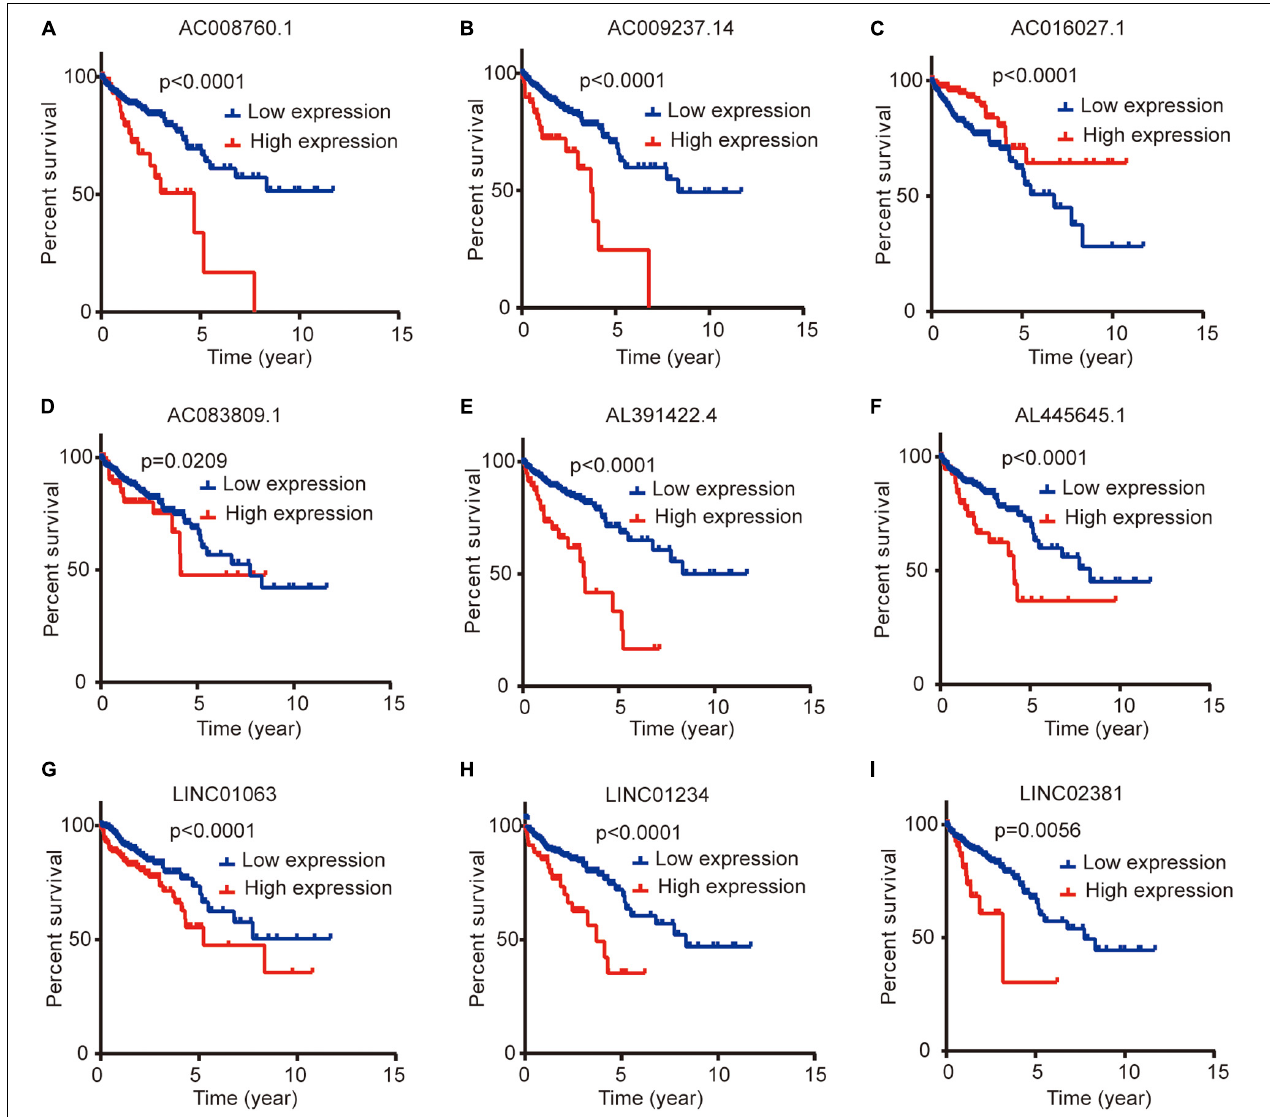
FIGURE 8 | Relationship between the expression levels of nine lncRNAs and survival prognosis of colon cancer. (A,B,D–I) Low and high expression levels of AC008760.1, AC009237.14, AC083809.1, AL391422.4, AL445645.1, LINC01063, LINC01234, and LINC02381 are associated with significantly different prognosis, and the high expression group has a worse prognosis than the low expression group in colon cancer. (C) Prognosis significantly differs between groups with high expression and low expression of AC016027.1, and the low expression group has a worse prognosis than the high expression